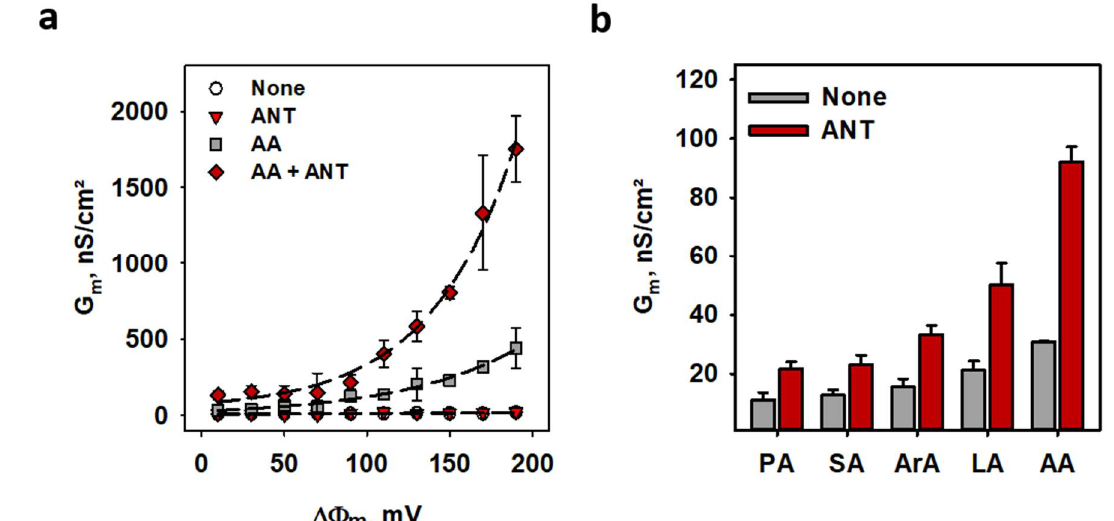
Figure 2. Fatty acids are required to activate ANT1-mediated proton transport. ( a ) Total membrane conductance (G m ) of lipid bilayers in the presence of AA (gray squares), ANT1 (red triangles), ANT1 and AA (dark red diamonds) and in the absence of AA and ANT1 (white circles) at different membrane potentials (ΔΦ m ). Lines represent the least square regression fit of an exponential function to the data. ( b ) Dependence of total membrane conductance (G m ) on fatty acid chain length and unsaturation in the presence (red) and absence (gray) of ANT1. PA, SA, ArA, LA, and AA indicate palmitic, stearic, arachidic, linoleic, and arachidonic acids. In all measurements, planar bilayer membranes were made of 45:45:10 mol % PC:PE:CL reconstituted with 15 mol % FA, except indicated otherwise. Lipid concentration was 1.5 mg/(mL of buffer solution). Protein concentration measured by BCA assay was 4 µg/(mg of lipid). The buffer solution contained 50 mM Na 2 SO 4 , 10 mM Tris, 10 mM MES and 0.6 mM EGTA at pH = 7.34 and T = 306 K. Data are the mean ± SD of at least three independent experiments.